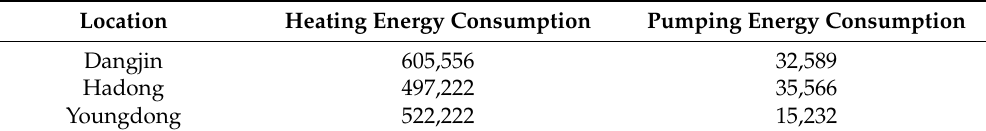
Table 5. Heating and pumping energy consumption (kWh/ha).